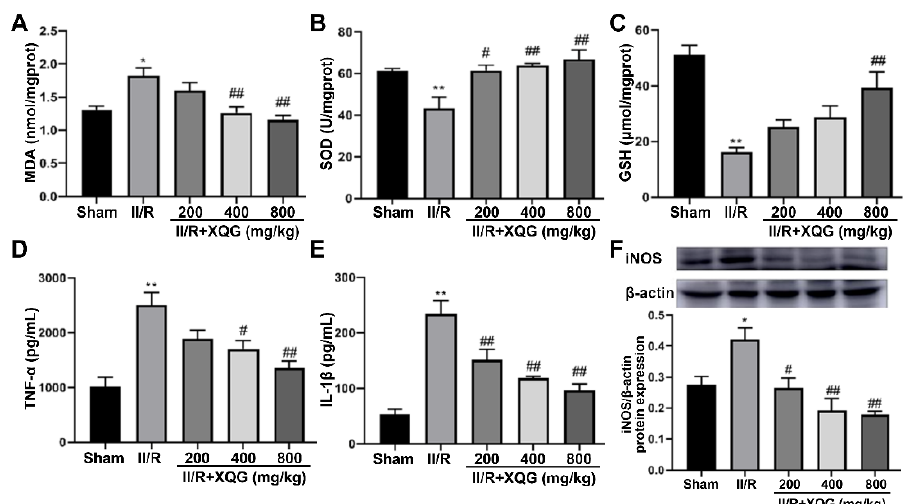
Figure 4. XQG alleviated oxidative stress and inflammatory response induced by II/R. Effects of XQG on ( A ) MDA; ( B ) SOD; ( C ) GSH; ( D ) TNF- α ; ( E ) IL-1 β ; and ( F ) iNOS in intestinal tissues. All values were expressed as mean ± SEM ( n ≥ 3). compared with sham group, * p < 0.05 and ** p < 0.01 vs. sham group, # p < 0.05 and ## p < 0.01 vs. II/R group.